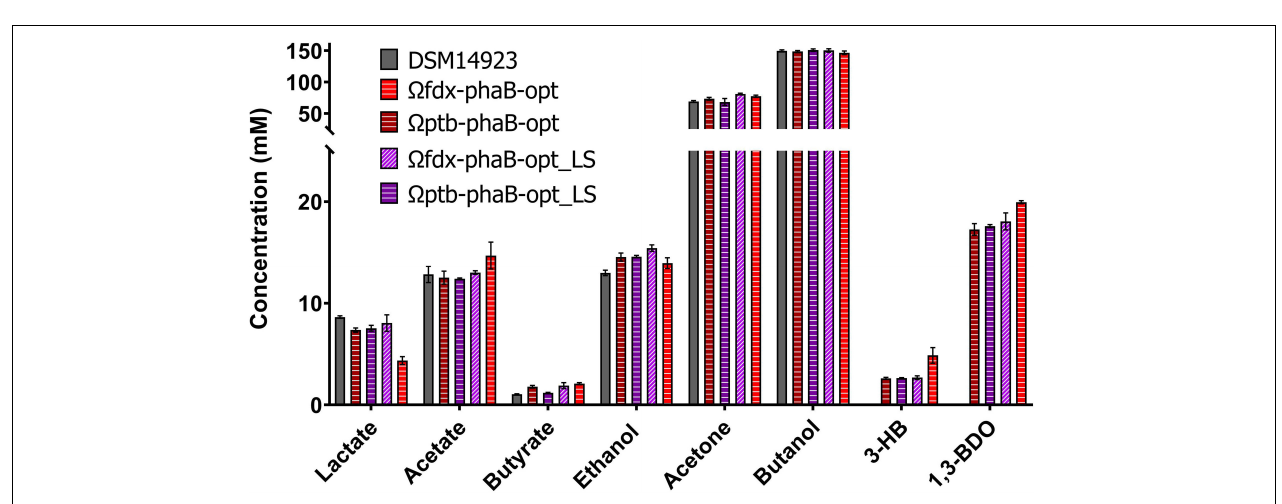
FIGURE 6 | Comparison of product spectrum of the codon optimised phaB version and its derivatives encoding PhaB point mutations expressed in C. saccharoperbutylacetonicum by either weak promoter P cspo_fdx or strong promoter P cac_ptb from the chromosomal pyrE locus after 48 h. From left to right for each product DSM14923 in black, (cid:127) fdx - phaB -opt in red horizontal lines, (cid:127) ptb - phaB -opt in burgundy horizontal lines, (cid:127) fdx - phaB -opt_LS in light purple diagonal lines and (cid:127) ptb - phaB -opt_LS in purple horizontal lines. Error-bars represent SEM ( n =